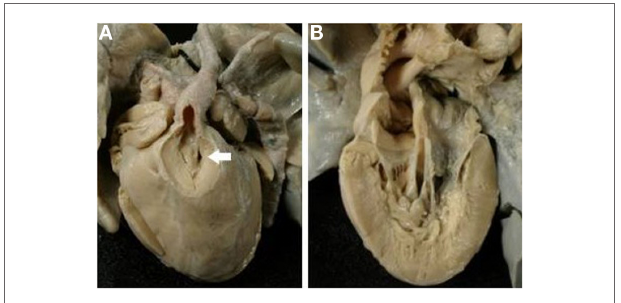
FigUre 12 | Discordant Va connection in double inlet left ventricle . (a) External view of the heart: the aorta takes origin from an anterior hypoplastic right ventricle (discordant VA connection). The arrow indicates the obstructive VSD (outlet foramen). The obstruction of the aortic arch was surgical relieved. (B) Two separated AV valves drain into the same ventricle of left morphology (double inlet left ventricle).